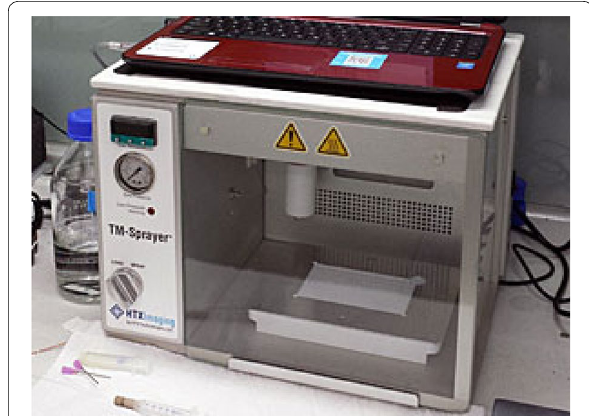
Fig. 1 The automated MALDI sample preparation platform, TM‑Sprayer